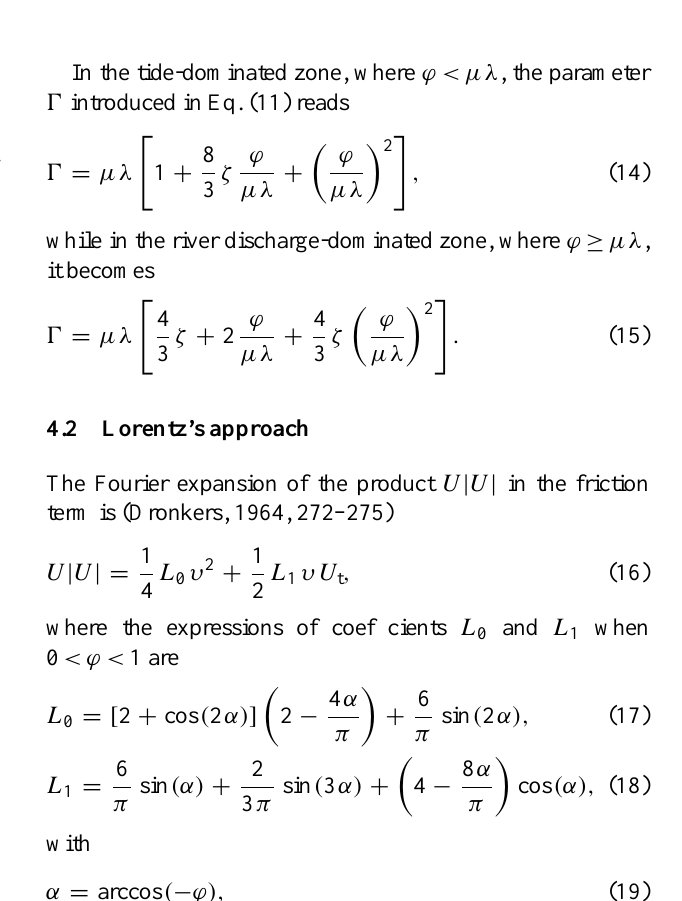
Fig. 2. Variation of damping number δ , the velocity number µ , celerity number λ and phase lag ε with the estuary shape number γ for different values of the friction number χ , obtained with the hybrid model. The green symbols represent the ideal estuary (see Table 2).